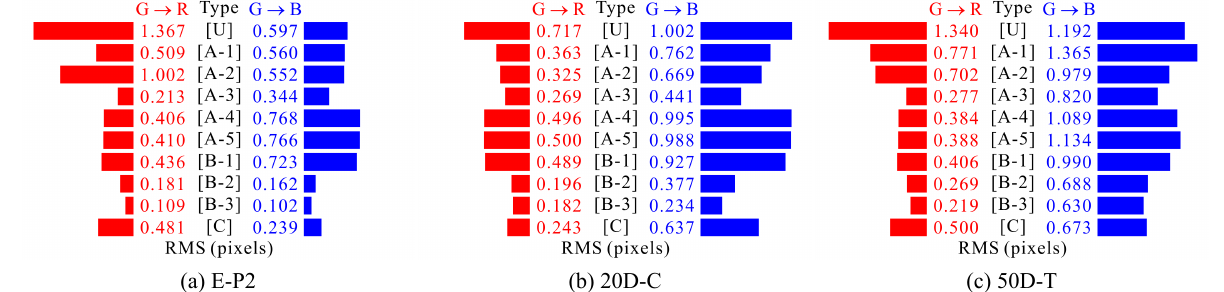
Figure 5. RMS of displacements of the uncorrected and corrected images